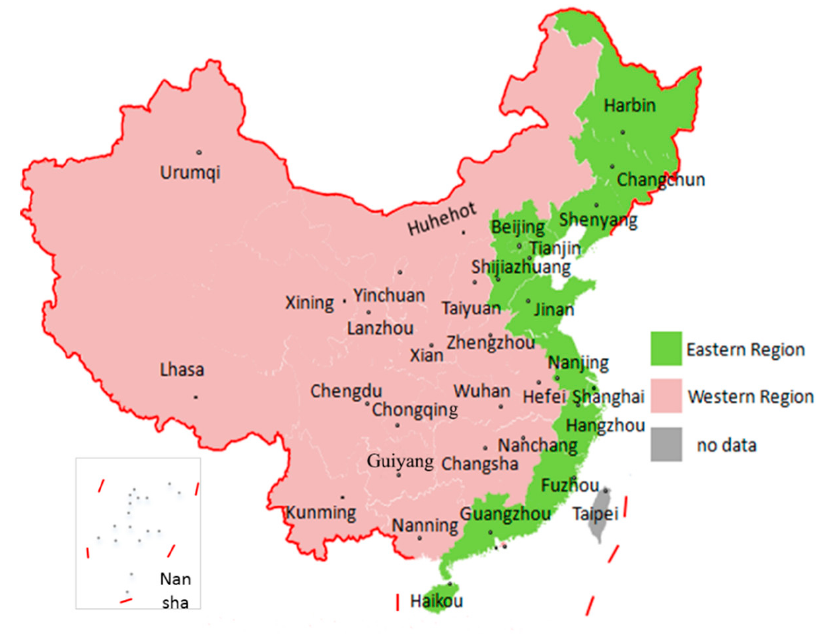
Figure 1. The thirty-one sample cities in the two regions, separated by those included in the Western analyses (red) and the Eastern analyses (green).